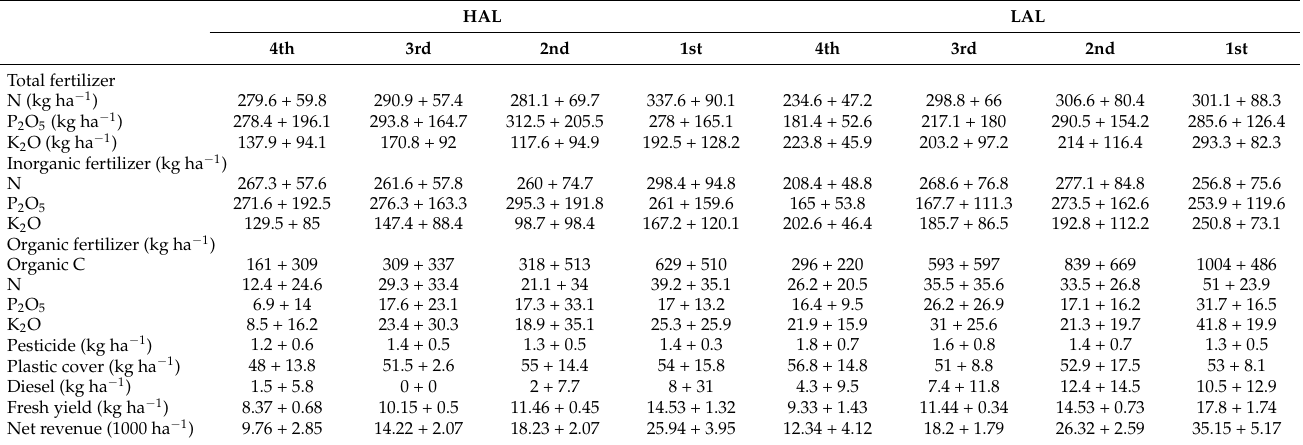
Table 3. Resource input rate and output of open-field pepper production system among different farmers groups in HAL and